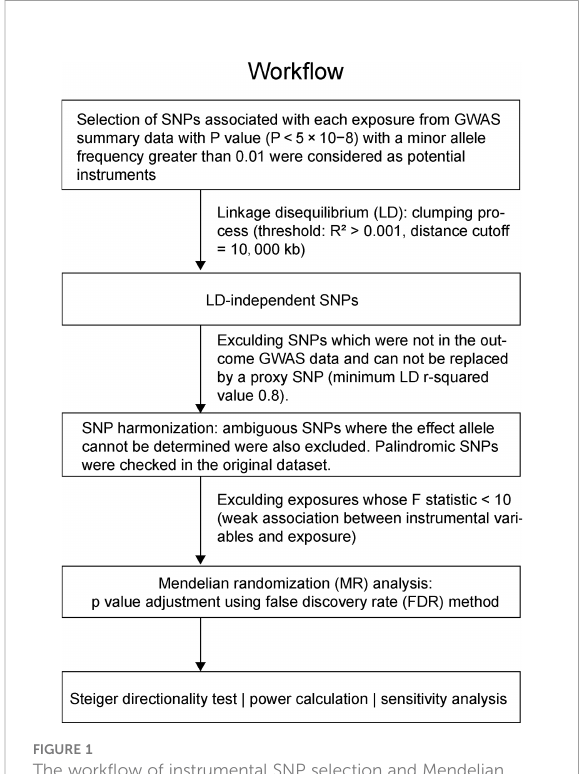
FIGURE 1 The work fl ow of instrumental SNP selection and Mendelian randomization (MR)